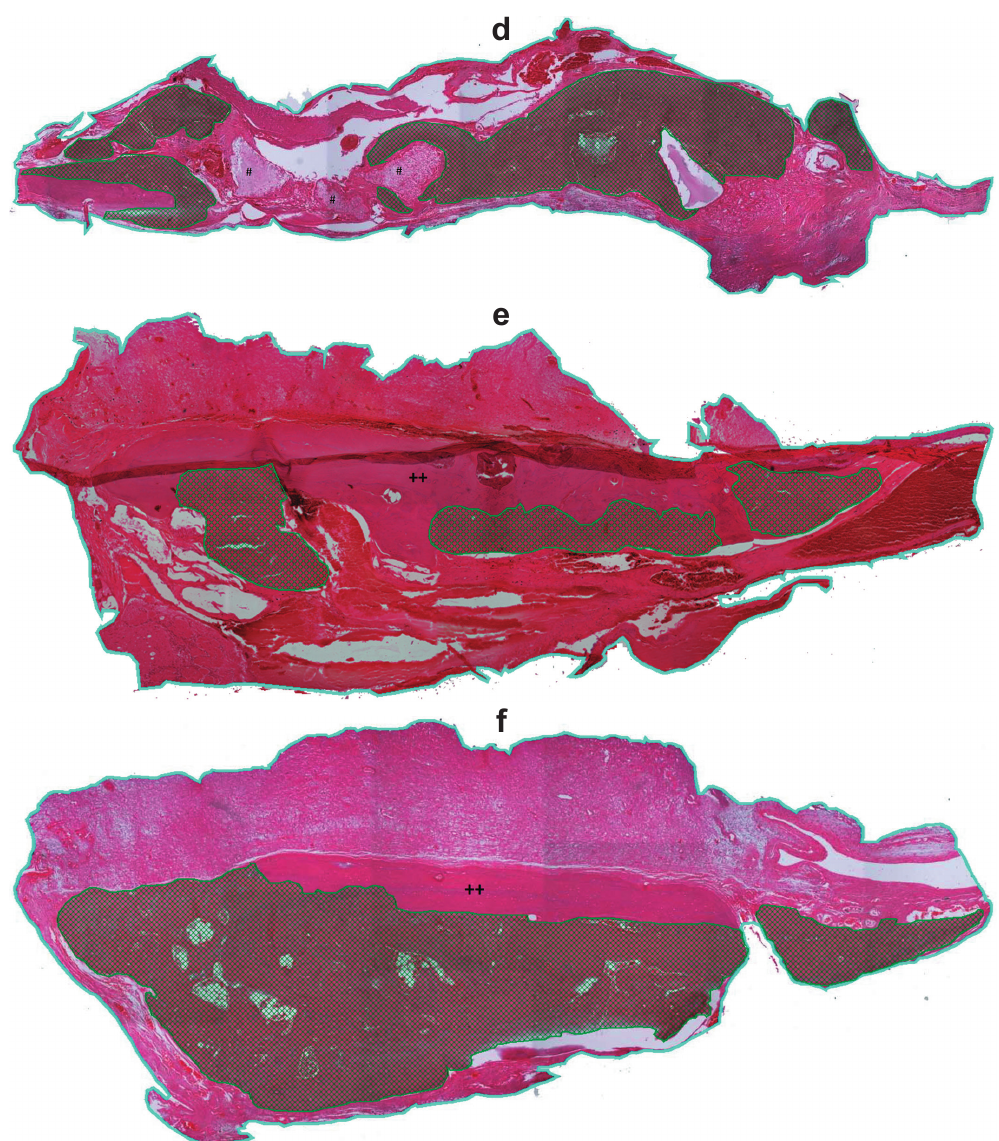
Figure 3- Histomorphometric analysis after reconstruction with autogenous bone graft, powdered synthetic hydroxyapatite implant, andallogeneic cartilage graft, with or without exposure to buried magnetic field, at 60 postoperative days (Blue lines define the total area of the bone defects, and cross hatched areas represent areas of new bone formation within the critical defect). d) Powdered synthetic hydroxyapatite group exposed to buried magnetic stimulation; e) Autogenous bone graft group not exposed to buried magnetic stimulation; f) Autogenous bone graft group exposed to buried magnetic stimulation. * indicates cartilage graft; # indicates hydroxyapatite implant; ++ indicates bone